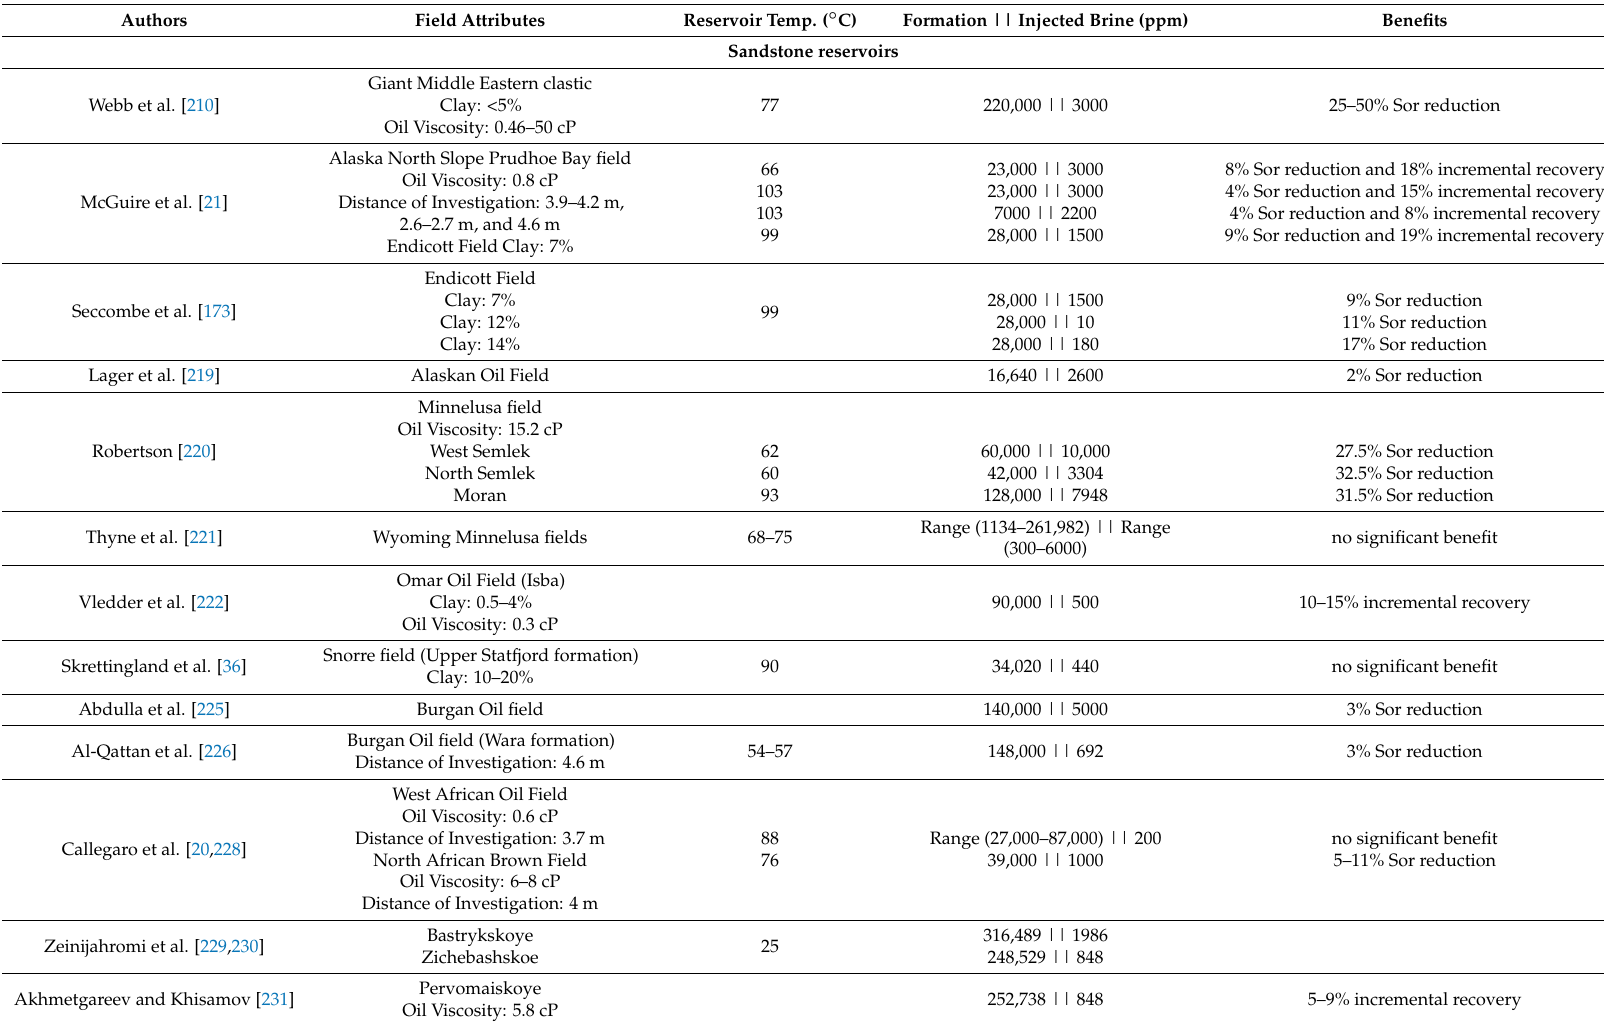
Table 2. Summary of main field implementations of brine-dependent recovery in sandstones and